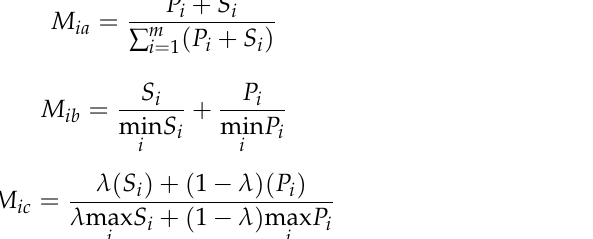
Phase 4— Computation of aggregated appraisal scores: M ia , M ib , M ic are